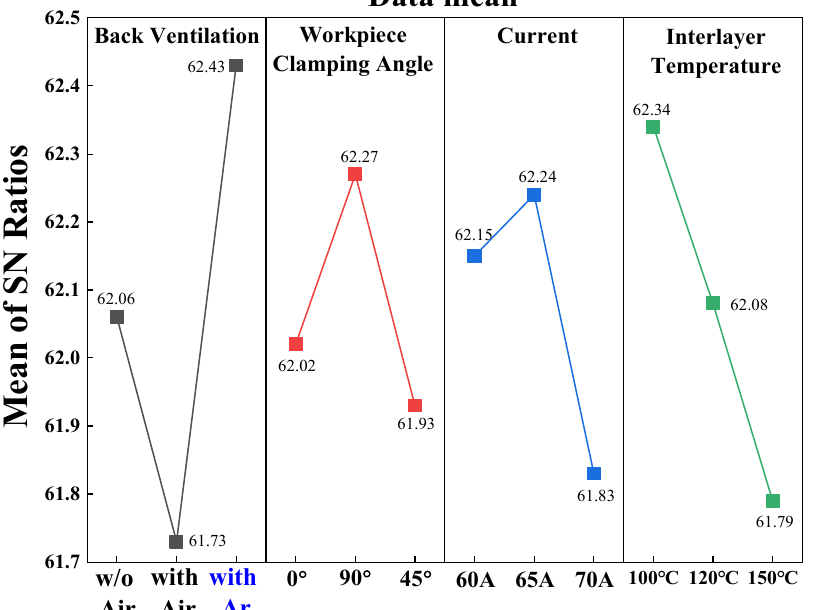
Figure 5. S / N ratio factor response graph of Vickers hardness test of UNS31803 duplex stainless in L9 direct cross